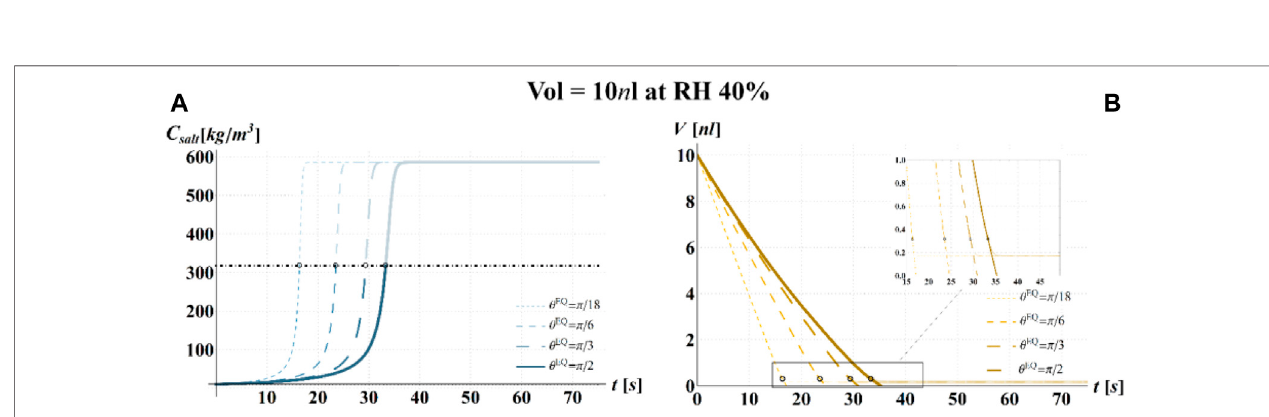
FIGURE6| Resultsofmodelsimulationsoftheevaporationprocessofasessiledropofaqueoussolutionwithastartingvolumeof10 nL,atanRH (cid:2) 40%,interms of time evolution of (A) the salt concentration, C salt , and (B) the volume, V, for fl at surfaces with different wettability, at T (cid:2) 25 ° C.